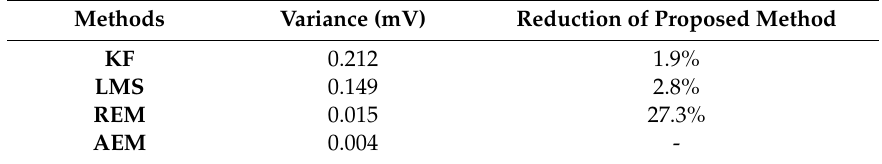
Table 3. Variance of equivalent input estimation under static condition with multi disturbances.